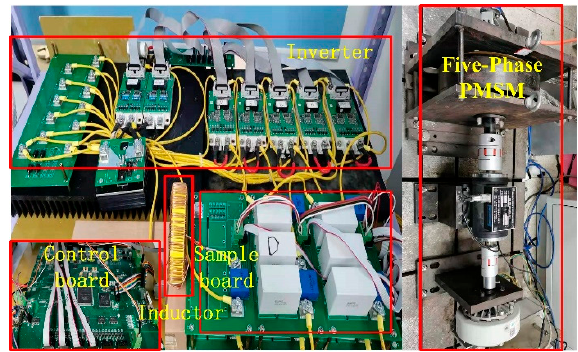
Figure 5. Experimental prototype with the five-phase CSI. Table 1. Parameters of the driver.